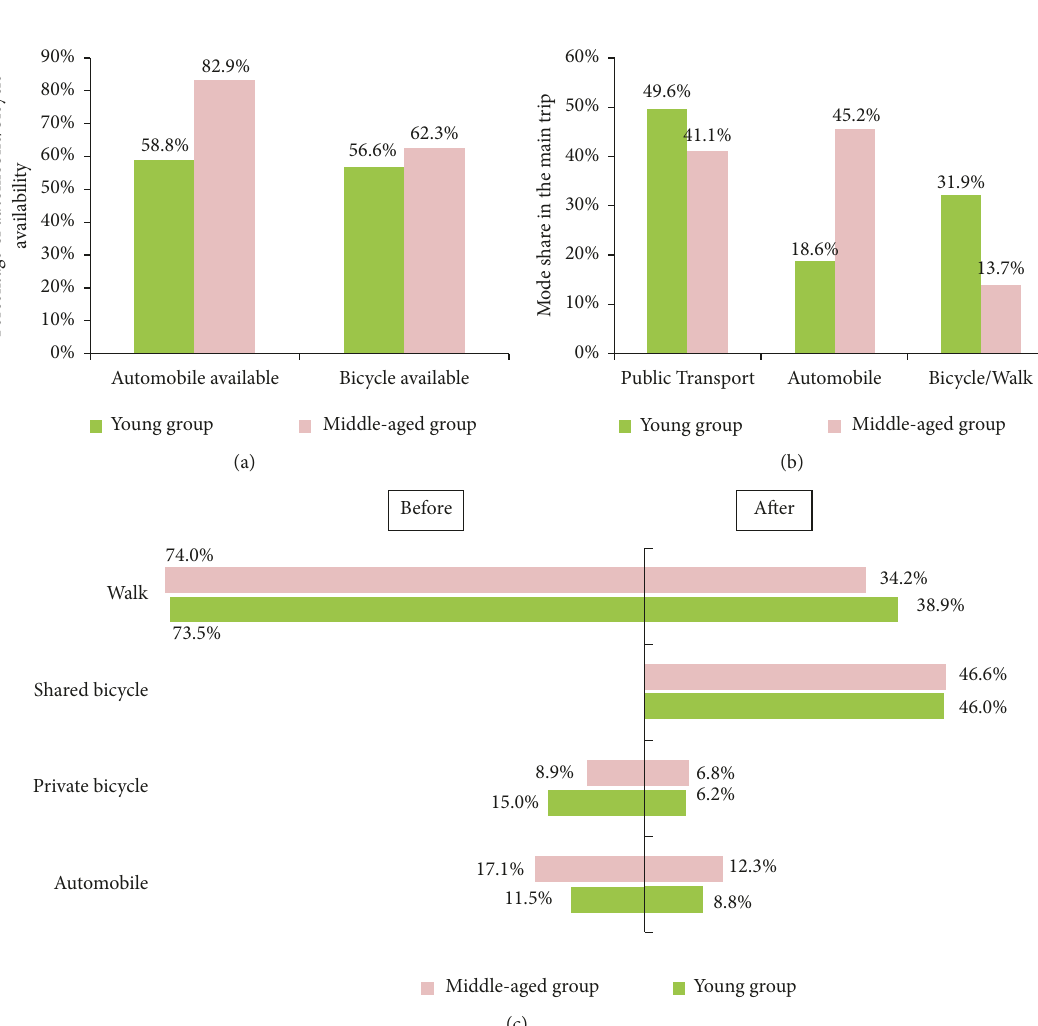
Figure 3: (a) Automobile/bicycle availability. (b) Mode choice in the main trip. (c) Mode choice for first/last mile trips before and after the introduction of shared